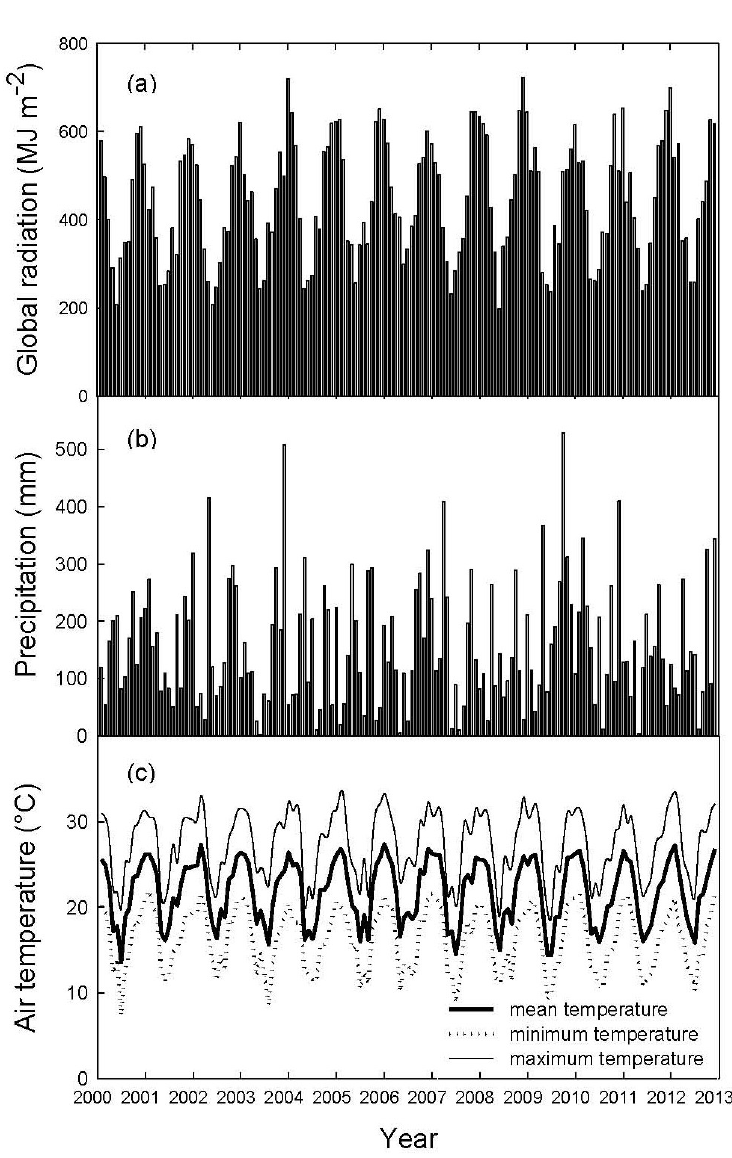
Figure 1. Seasonal variations of ( a ) monthly global radiation, ( b ) monthly total precipitation, and ( c ) monthly air temperatures obtained from daily mean temperatures from 2000 until 2012 (Puerto Iguazú-Aero Meteorological Station,